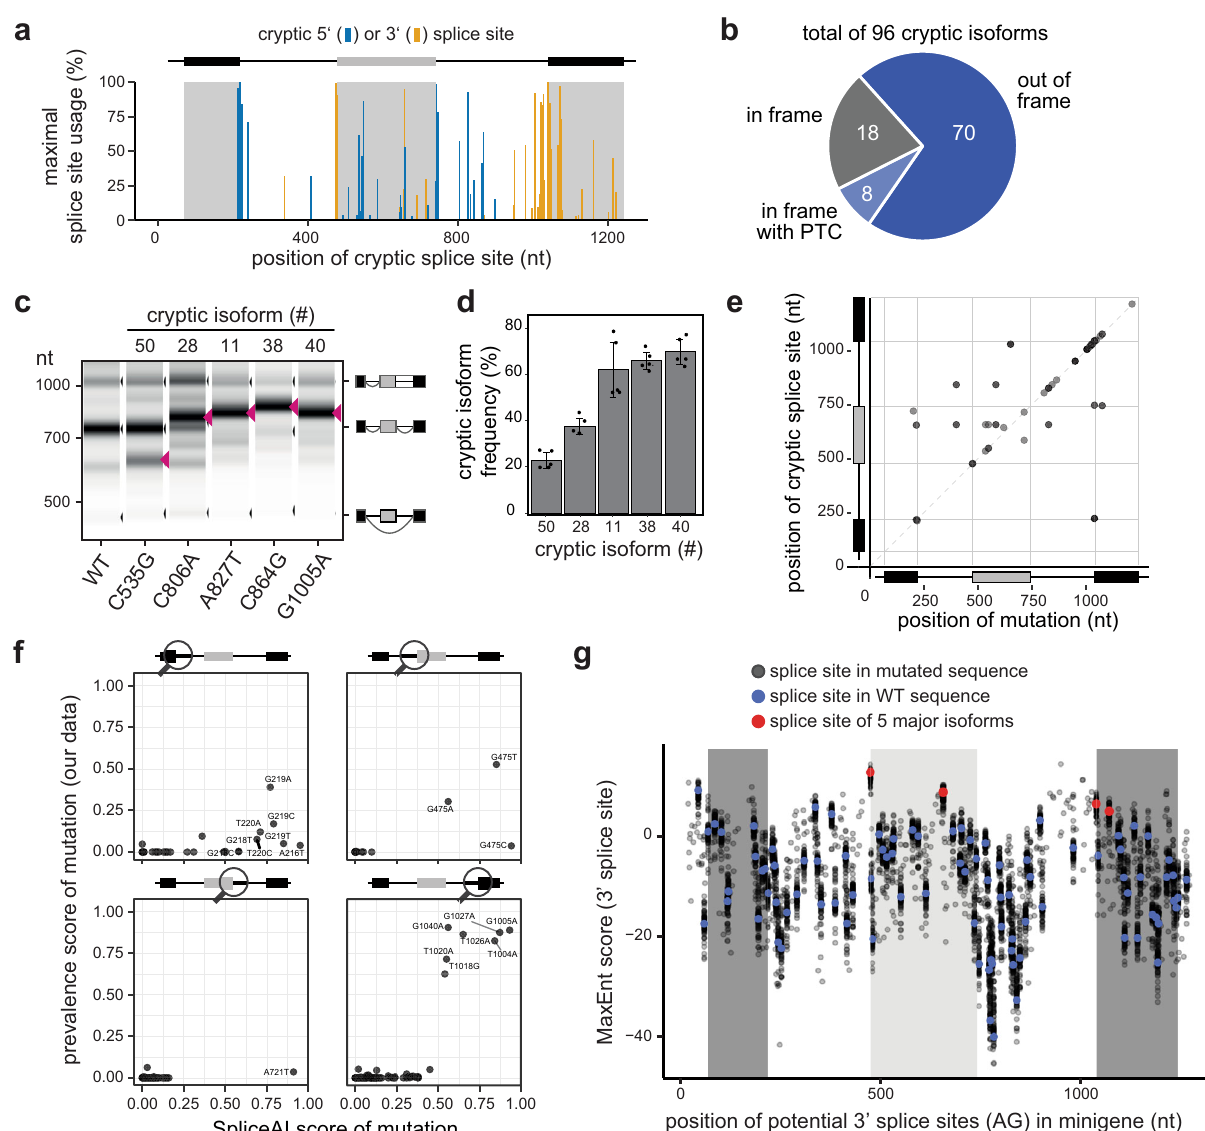
Fig. 4 CD19 mutations frequently activate cryptic splice sites. a Alternative splicing of CD19 minigene variants involves 71 cryptic splice sites. Splice site usage (sum of junction-spanning reads in a splice site / total number of reads in minigene) was calculated for each minigene variant. Maximum usage across all minigenes is plotted against the corresponding position to the cryptic splice sites. b Cryptic isoforms code for non-functional CD19 proteins. Out of 96 cryptic isoforms, 8 run into a premature termination codon (PTC) and 70 are out-of-frame. The remaining 18 remain in frame, but are shortened or extended relative to the reference inclusion isoform. c , d Experimental validation of fi ve point mutations associated with distinct cryptic isoforms. Predicted cryptic isoforms are indicated by red arrowheads. Gel-like representation ( c ), with major isoforms indicated on the right, and RT-PCR quanti fi cation ( d ). Error bars indicate s.d.m., n = 3 replicates. e Mutations leading to cryptic isoforms are often located within or near cryptic splice sites. For 31 cryptic isoforms that are highly associated with a mutation (prevalence score > 0.25; y axis), the position of the mutation ( x axis) was related to the used cryptic splice site ( y axis). f SpliceAI correctly predicts single mutations leading to the generation of cryptic isoforms. SpliceAI scores of 0 – 1 re fl ecting the probability to gain a cryptic splice site in response to a mutation (see Methods). Scatterplots compare the SpliceAI score against the prevalence score (association of a mutation with a cryptic isoform) from our data, for 254 mutation-splice site pairs that match in their positions with SpliceAI. Separate panels are shown for each canonical splice site (circle in schematic minigene representation). g Exon 3 harbours a weak 3 ′ splice site and is preceded by many potentially competing cryptic 3 ′ splice sites. Dotplot shows splice site strengths (MaxEnt score) for putative 3 ′ splice sites (AG dinucleotides) in the CD19 minigenes. MaxEnt score was calculated in 23-nt sliding window for WT sequence (red and blue dots) and hypothetical mutant minigenes with all possible single-point mutations (grey dots). 3 ′ splice sites used in the fi ve major isoforms are highlighted in red. Source data are provided as a Source Data fi To link the putative RBP regulators to the observed splicing affecting mutation (affecting any of the fi ve major isoforms). changes, we overlaid the predicted binding sites (or predicted Furthermore, 105 (5%) of the mutations predicted to change RBP mutations for DeepRiPe) with splicing-affecting mutations from binding by DeepRiPe overlap with splicing-affecting mutations, our screen. Overall, we fi nd that 79% and 60% of ATtRACT and suggesting that modulating RBP binding at these sites may have a oRNAment binding sites, respectively, overlap with a splicing- functional impact on CD19 splicing (Fig. 5c, Supplementary